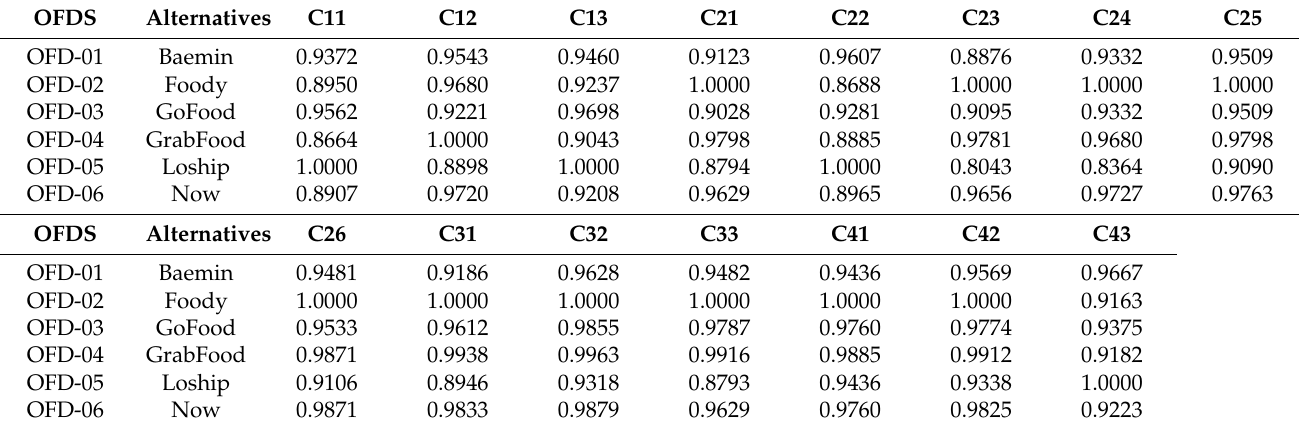
Table 10. The exponentially weighted normalized matrix for WPM (WASPAS